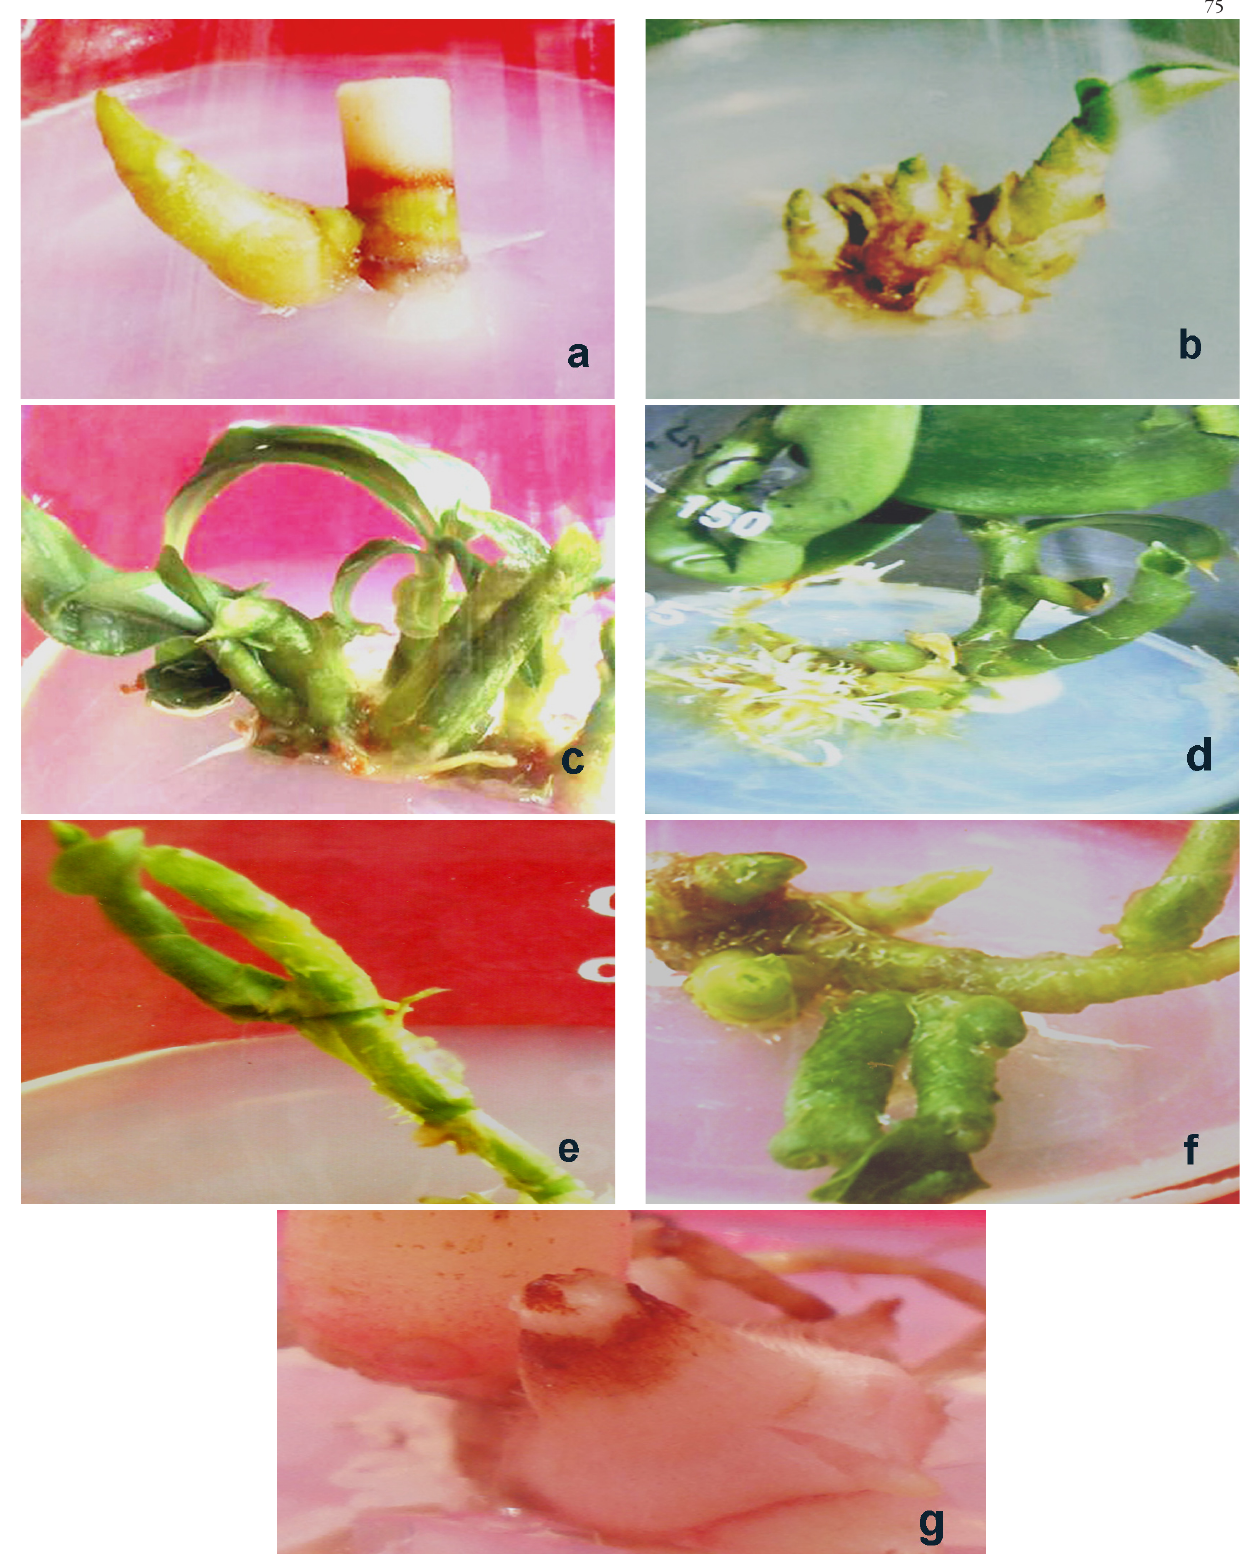
Fig. 1. Micropropagation of Costus pictus , (a) axillary bud sprouting from single node segments in MS + 3 µM BAP + 0.6 µM NAA, (b) axillary shoot proliferation in MS + 5 µM BAP + 0.6 µM NAA + 5% sucrose, (c) axillary shoot proliferation in MS + 8 µM BAP + 0.6 µM NAA, (d) axillary shoot proliferation and rooting in MS + 3 µM BAP + 8 µM IAA, (e) axillary bud sprout in MS + 7 µM BAP + 0.6 µM NAA + 7% sucrose, (f) axillary bud sprout in MS + 7 µM BAP + 0.6 µM NAA + 9% sucrose, (g) Microrhizome induction of in ½ MS + 2.4 µM NAA + 32 µM BAP + 9%